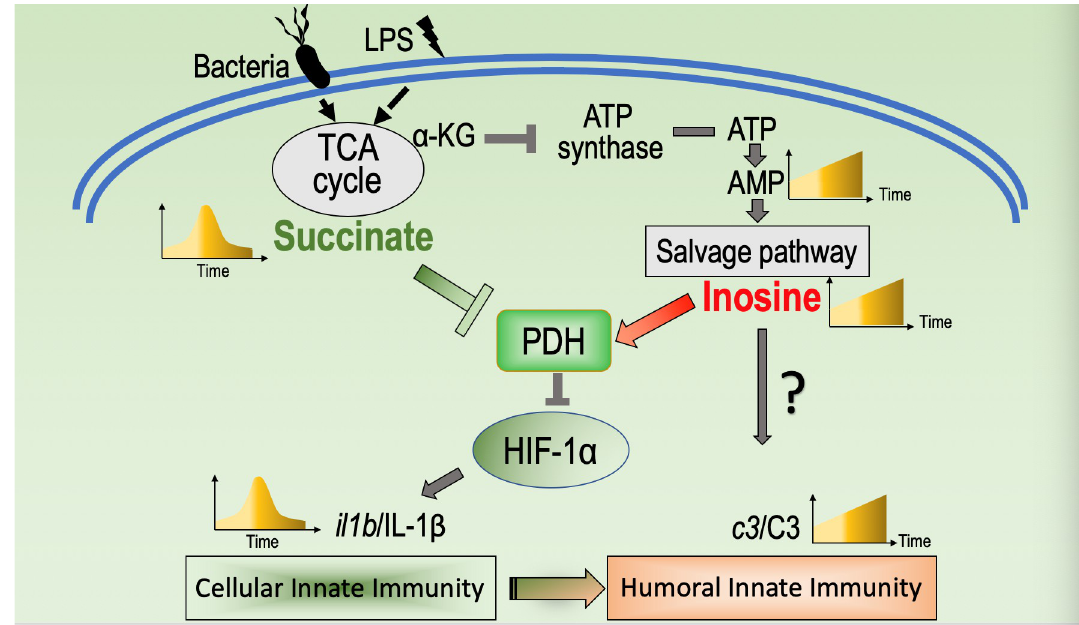
Fig 7. Proposed model. LPS or bacterial infection interrupted the normal TCA cycle that causes the kinetic expression of succinate and inosine, which corresponds the kinetic expression of il1b /IL1 β and c3 /C3, respectively, representing a metabolic regulation of the transition from cellular innate immunity to hurmoral immunity. Succinate inhibits the enzymatic activity of PHD that promotes the degradation of HIF-1 α at the phase of cellular innate immunity. But inosine competitively bind to PHD to rescue the activity of PHD at the phase of humoral innate immunity to promote the occurrence of humoral innate